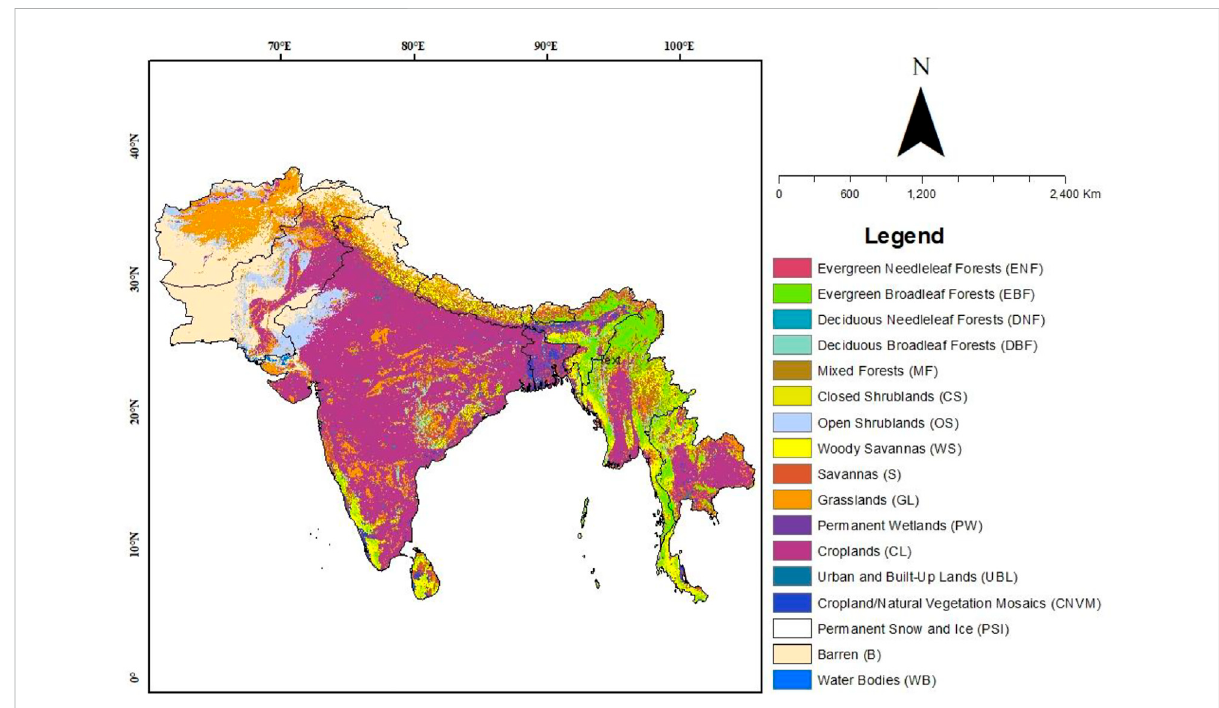
FIGURE 1 Land-cover type map of SEA, that was identi fi ed from MODIS (MCD12Q1) images using IGBP classi fi